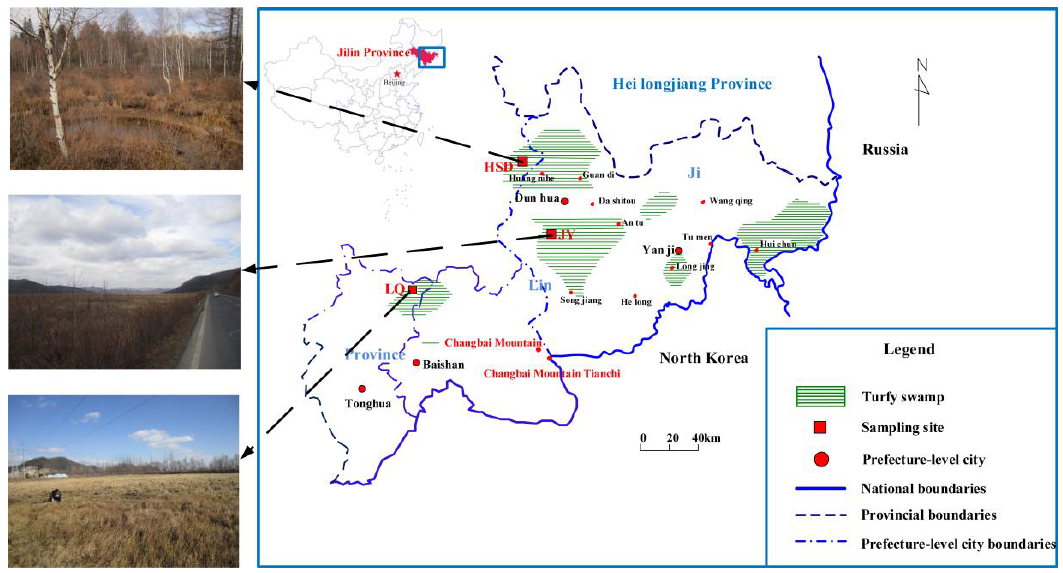
Figure 1. Study area and sampling sites in the Changbai Mountain area, Jilin Province.